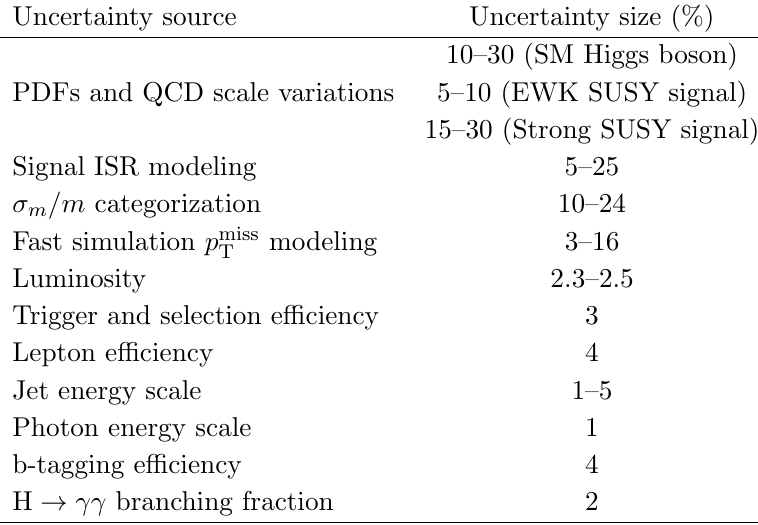
Table 4 . Summary of systematic uncertainties on the SM Higgs boson background and signal yield predictions, and the size of their e(cid:11)ect on the signal